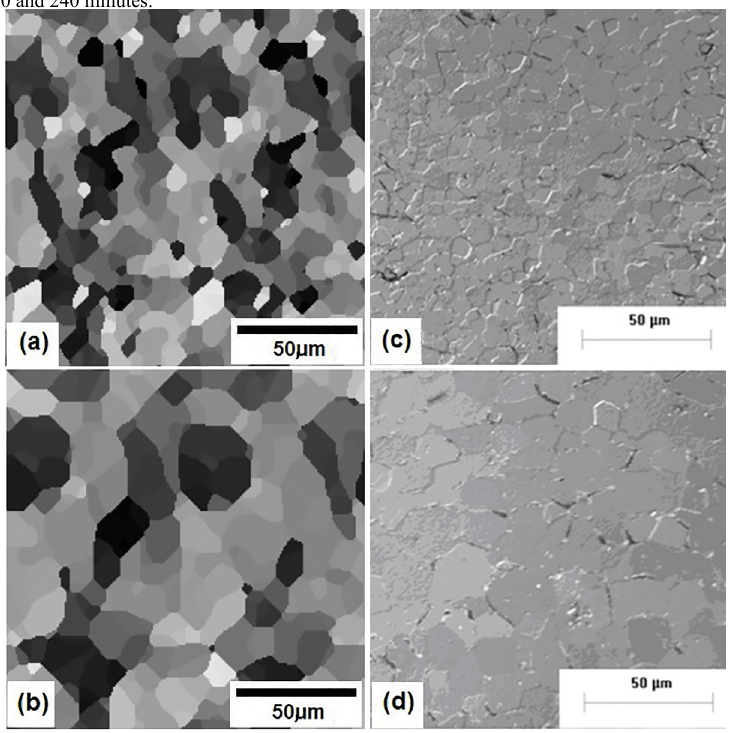
Figure 7: Temporal evolution of grain structure at a temperature of 948 K after 60 and 240 minutes: (a) and (b) simulated, (c) and (d) micrographs of grain structure obtained experimentally 21